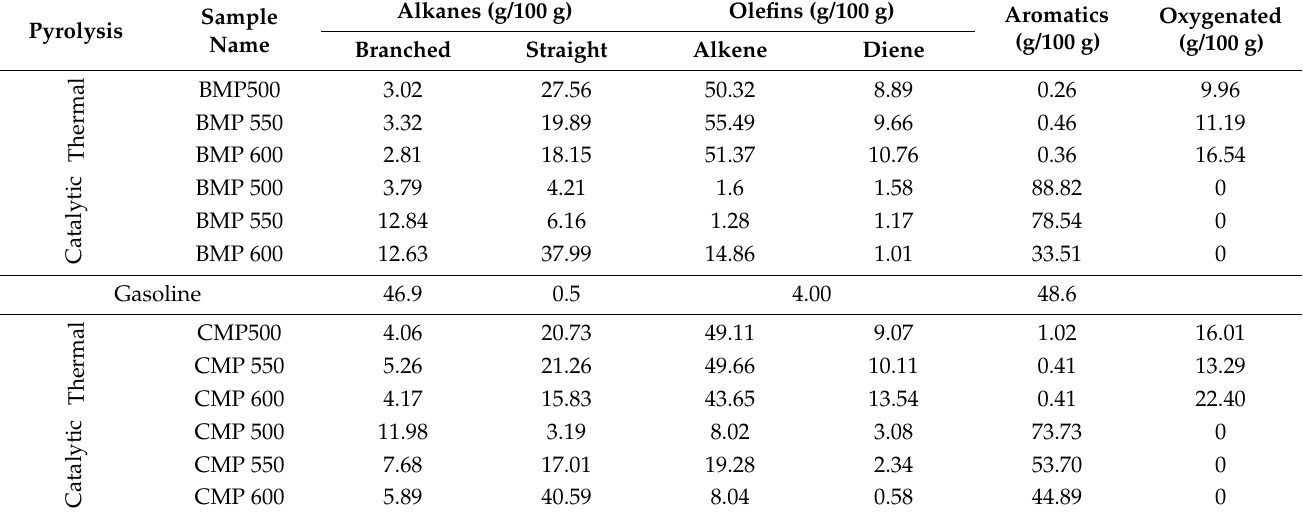
Table 7. Yields (g/100g) of branched alkanes, straight alkanes, alkanes, diene, aromatics, and oxygenated compounds in the pyrolysis (thermal and catalytic) products at 500, 550 and 600 ◦ C from BMP and CMP. The proportions are also shown for gasoline as a basis of